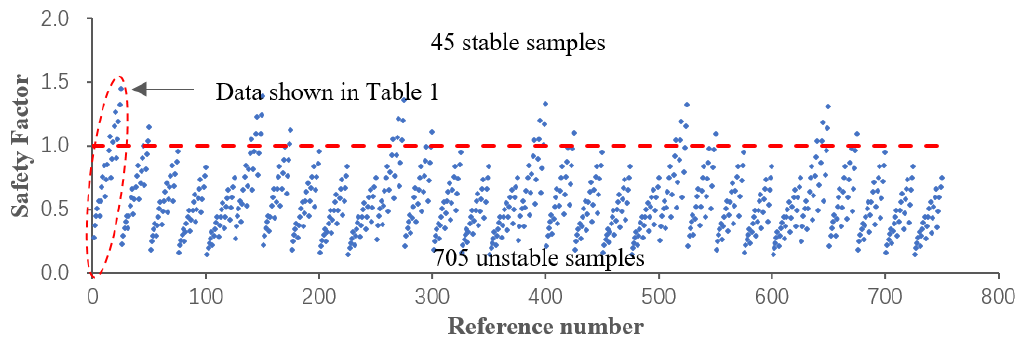
( d ) Figure 3. Comparison of safety factors computed in 2D and 3D simulations: ( a ) 𝐶 = 15 m, 𝐷 = 10 m, 𝑐 = 5 kPa ; ( b ) 𝐶 = 15 m, 𝐷 = 10 m,𝑐 = 10 kPa ; ( c ) 𝐶 = 20 m,𝐷 = 5 m, 𝑐 = 5 kPa ; ( d ) 𝐶 = 20 m, 𝐷 = 5 m,𝑐 = 10 kPa . For the cases with 𝐶 = 5 m and 𝐷 = 5 m , the simulated safety factors were collected and listed in Table 1, in which the safety factors greater than 1.0 were indicated with red dashed rectangles. As mentioned above, the 25 samples can be classified into 7 stable samples and 18 unstable samples according to the simulated safety factors. Similarly, the other 725 strength reduction analyses were performed, and the collected safety factors are plotted versus the reference numbers and shown in Figure 4, in which a red dashed line with 𝐹 𝑠 = 1 was added to classified the collected samples into two categories, i.e., 45 stable samples and 705 unstable samples. Thus, the prior probabilities of the stable and unstable states are available: 𝑃(Stable) = 45 750 = 0.06; (13) 𝑃(Unstable) = 750 − 45 750 = 0.94.